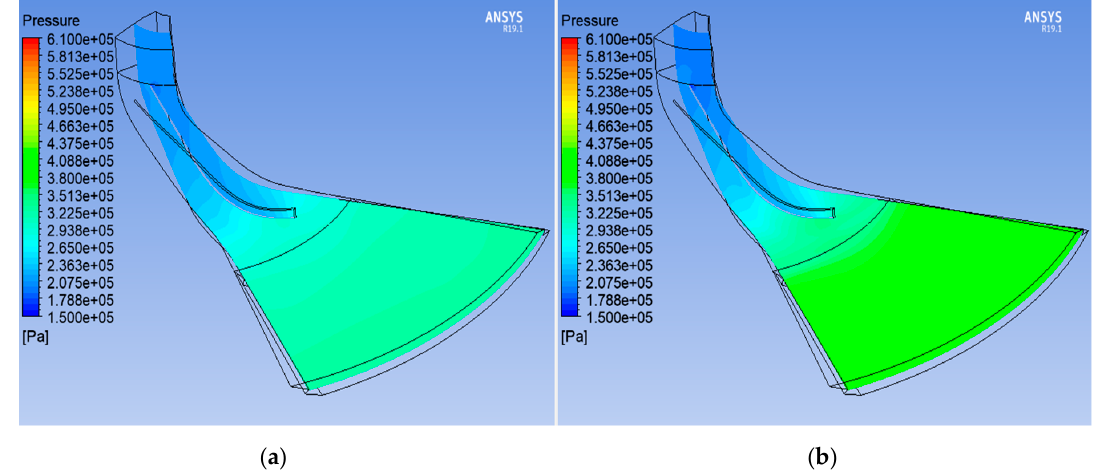
Figure 5. Pressure Contour for R1234ze at an RPM of 35,000 ( a ) and 40,000 ( b ).